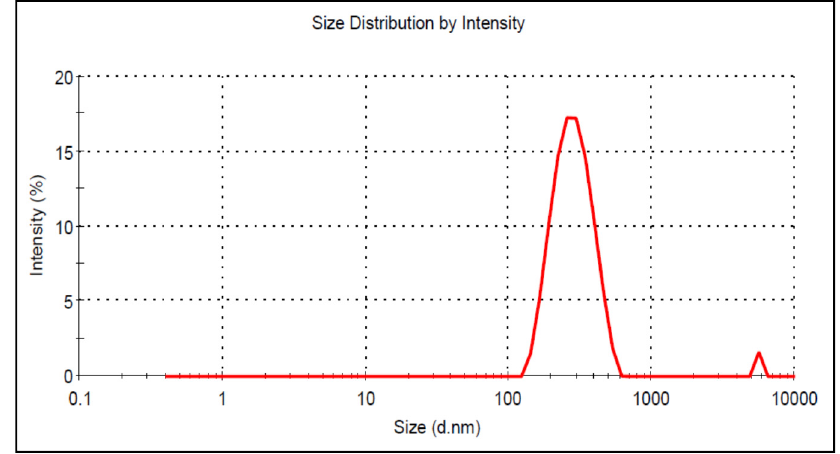
Figure 1. Particle size image of KaempeferolNps (DNP 7). Table 2. Physicochemical data of KaempferolNps formulation. Study has been performed in triplicate and shown as mean ±